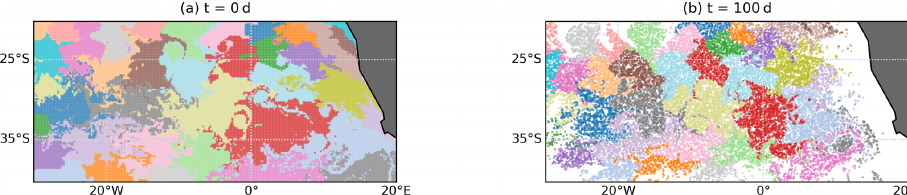
Figure C2. Result of k -means clustering applied to the 40 leading eigenvectors of the random walk Laplacian (see Eq. C2), looking for 40 clusters. No individual vortices are detected.